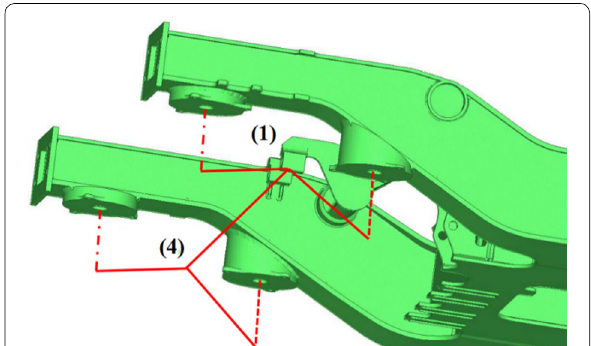
Figure 3 Virtual axle model simulating the primary suspension, rubber spring, axle, axle box, and the connecting relationship between